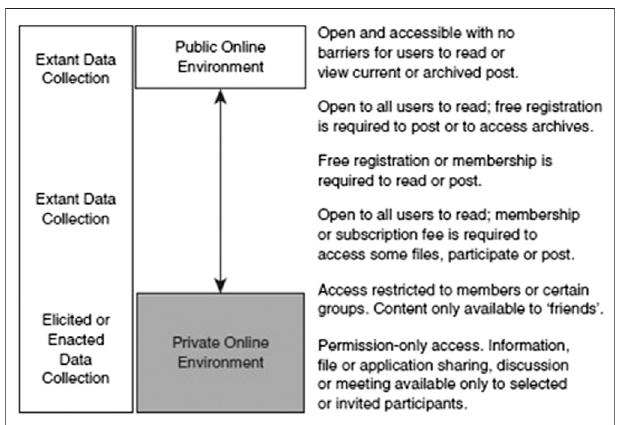
FIGURE 1 | The public – private internet continuum. source (Salmons 2014, p. 156. Citing Vision2Lead, Inc. 2013).